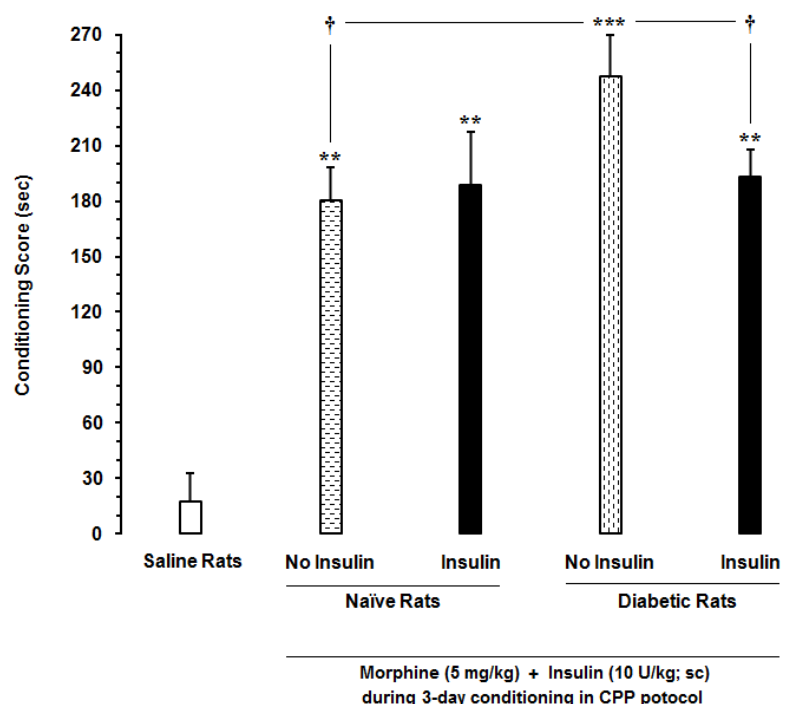
FIGURE 4 - Effect of insulin on the acquisition of morphine-induced place preference (relevant to Figures 1B and C).